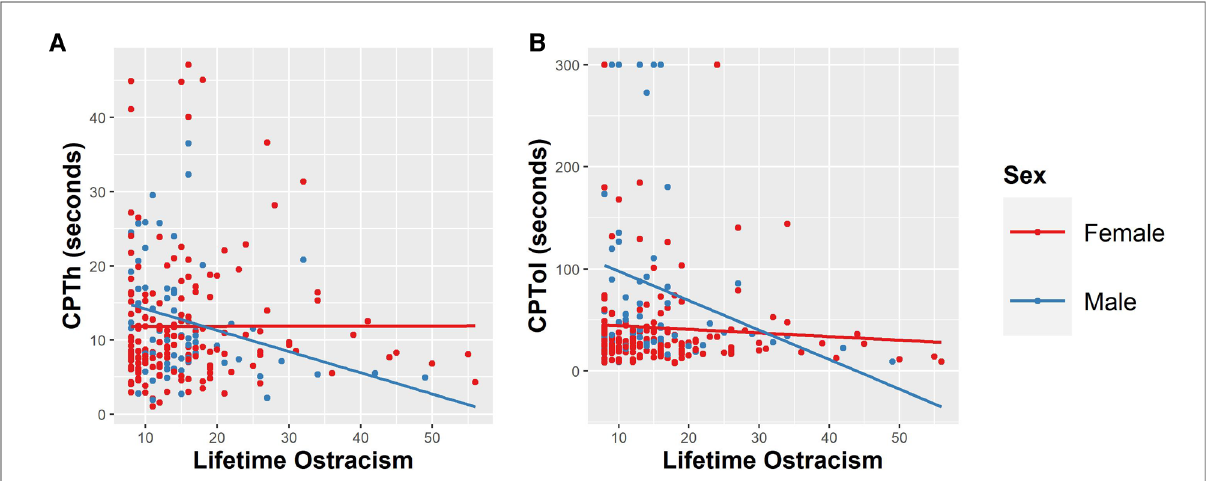
FIGURE 1 Sex signi fi cantly ( p <0.05) moderated the relationship between lifetime ostracism experiences and ( A ) cold pain threshold (CPTh sec ) and ( B ) cold pain tolerance (CPTol sec ). The raw, untransformed values are presented in the fi